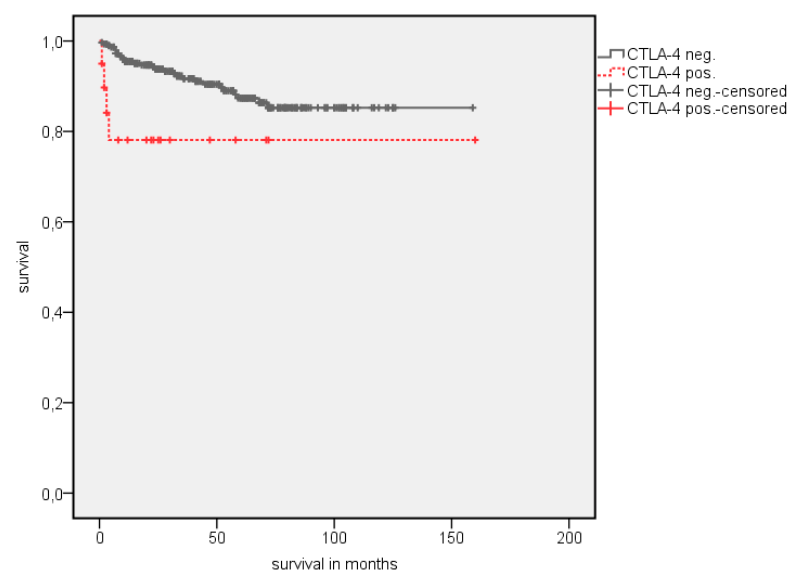
Figure 4. Kaplan Meier analysis: Association of CTLA-4 expression in TIMC with OS in all RCC patients.